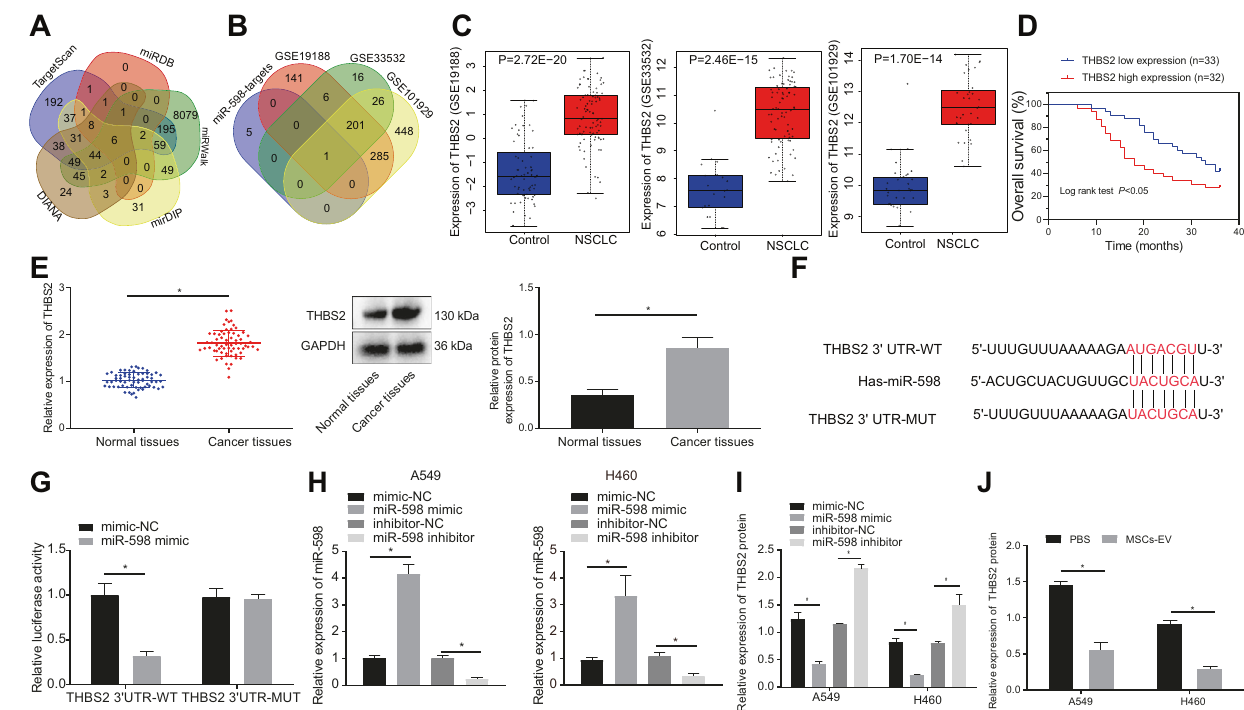
Fig. 5 Relationship between THBS2 and miR-598. A Intersection of the miR-598 target genes predicted by TargetScan, miRDB, miRWalk, mirDIP, and DIANA databases. B Intersection of the differentially expressed genes in GSE19188, GSE33532, and GSE101929 datasets and the miR-598 target genes. C THBS2 expression in the GSE19188, GSE33532, and GSE101929 datasets. D Correlation between THBS2 expression and prognosis of NSCLC patients by Kaplan – Meier analysis. E The mRNA and protein expressions of THBS2 in tumor tissues and adjacent normal tissues of NSCLC by RT-qPCR and Western blot analyses. F The speci fi c binding sites between miR-598 and THBS2 predicted online (Targetscan). G Targeting relationship between miR-598 and THBS2 veri fi ed by dual luciferase reporter assay. H Expression of miR-598 in A549 and H460 cells after different transfections by RT-qPCR. I THBS2 protein level in A549 and H460 cells after different transfections by Western blot analysis. J THBS2 protein level in A549 and H460 cells treated with MSCs-EVs by Western blot analysis. * p < 0.05 between two groups. Data between tumor tissues and adjacent normal tissues were compared by paired t test. Data between two groups were compared by unpaired t test. Cell experiments were repeated three Next, CCK-8 and Transwell assay results showed that the prolifera- tion, migration, and invasion abilities of A549 and H460 cells were promoted by THBS2 overexpression but suppressed by THBS2 knockdown (Fig. 6C – E). Taken together, the above data proved that THBS2 promoted the proliferation, migration, and invasion capabil- ities of NSCLC cells. MSCs-EVs-derived miR-598 down-regulates THBS2 to inhibit the proliferation, migration, and invasion capabilities of NSCLC cells in vitro To further explore the effects of miR-598 transferred by MSCs-EVs on the biological functions of NSCLC cells by targeting THBS2, we treated A549 and H460 cells with MSCs-EVs and pcDNA-THBS2 plasmid. RT-qPCR showed that the expression of miR-598 was increased in the A549 and H460 cells after this MSCs-EV treatment, while pcDNA-THBS2 plasmid had no effect on the expression of miR-598 (Fig. 7A). Western blot analysis further revealed that MSCs-EVs treatment inhibited the protein level of THBS2 in the cells, while co-treatment with MSCs-EVs and pcDNA-THBS2 enhanced the protein level of THBS2 (Fig. 7B). CCK-8 and Transwell experimental results displayed that MSCs-EVs inhibited the proliferative, migration and invasive capabilities of NSCLC cells, which, conversely, were promoted by overexpressing THBS2 (Fig. 7C – E). Besides, Western blot analysis revealed that, compared with the untreated cells, the expression of Ki67, Vimentin, MMP-9, Slug, and Twist was reduced in the MSCs-EVs-treated cells, while the expression of E-cadherin was increased. When compared with the MSCs-EVs + pcDNA-vector treatment, the MSCs-EVs + pcDNA- THBS treatment was observe to increase the expression of Ki67,